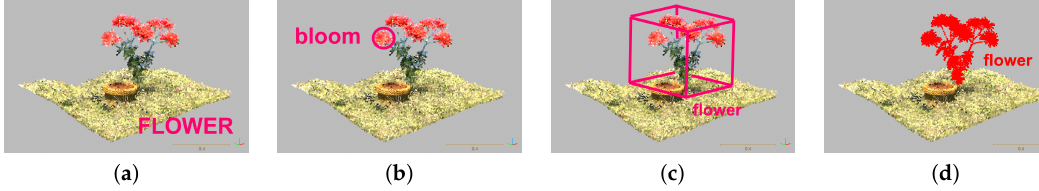
Figure 2. Types of 3D model annotation: ( a ) model tag; ( b ) landmark point; ( c ) bounding box; ( d ) individual points. Point cloud from 3DRMS dataset